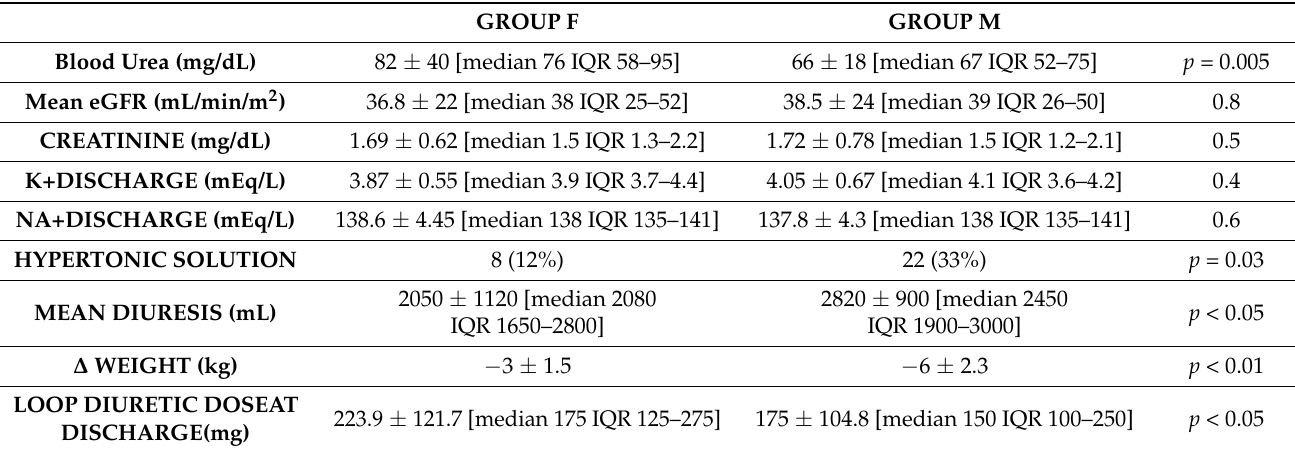
Table 3. Effects of metolazone plus furosemide (Group M) vs. furosemide alone (Group F) administration on renal function electrolyte balance and saline solution. Metolazone addition showed significant weight loss and less oral loop diuretic amount at discharge.